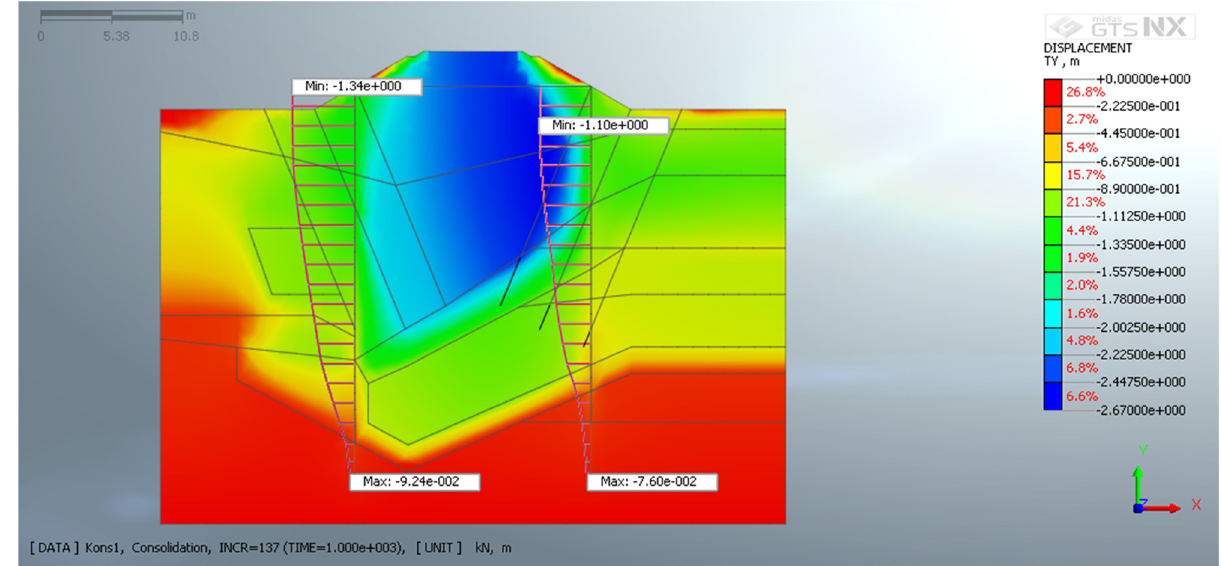
Figure 13: Vertical displacement map after